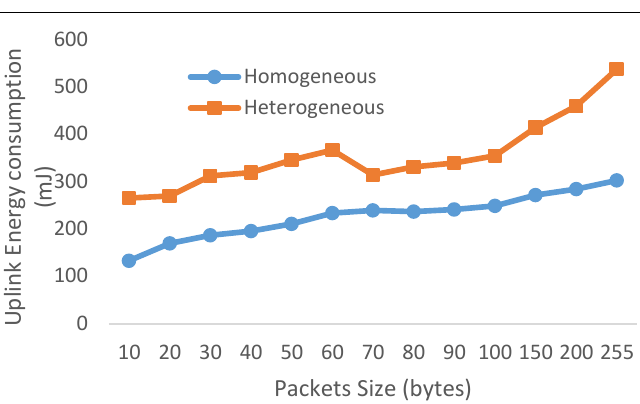
Figure 12: Energy consumption with packet size. Source: Authors,